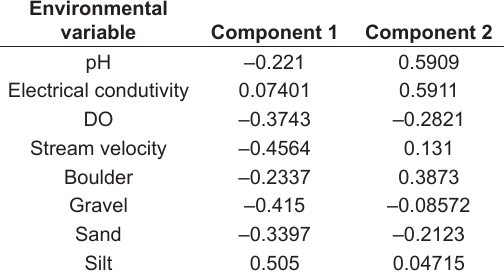
Table 2. Results of Principal Components Analysis of environmental variable data from 29 small streams in São Paulo State: correlation coefficients of Components 1 and 2 and the variables.